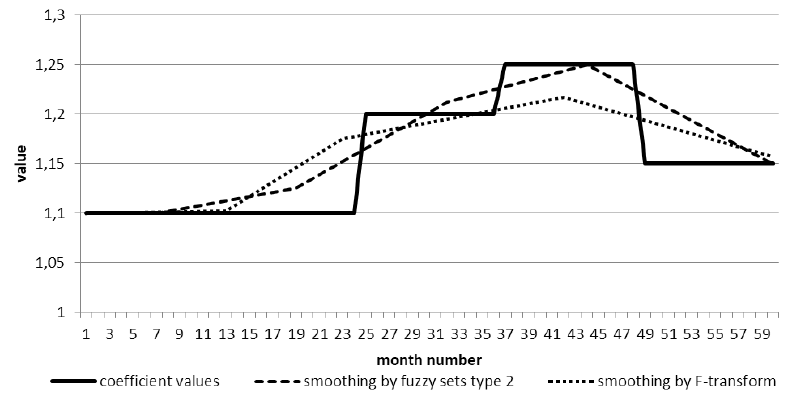
Figure 11. Coefficient time series